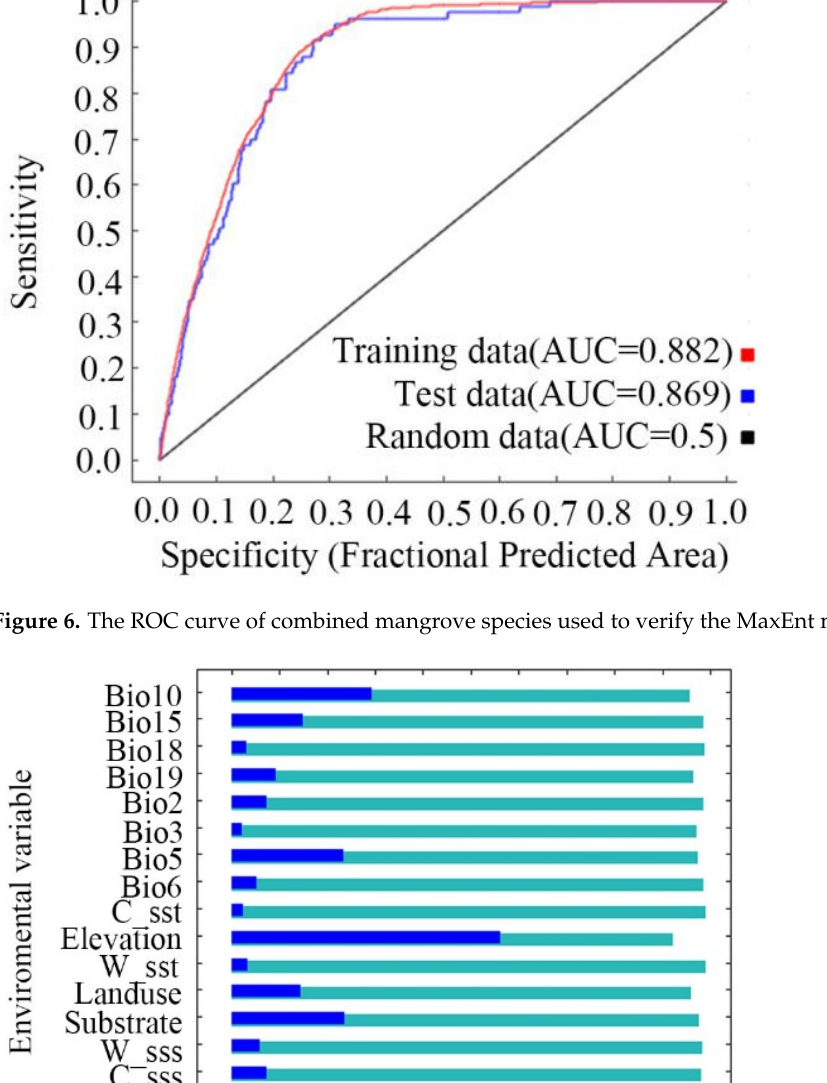
Figure 6. The ROC curve of combined mangrove species used to verify the MaxEnt model.